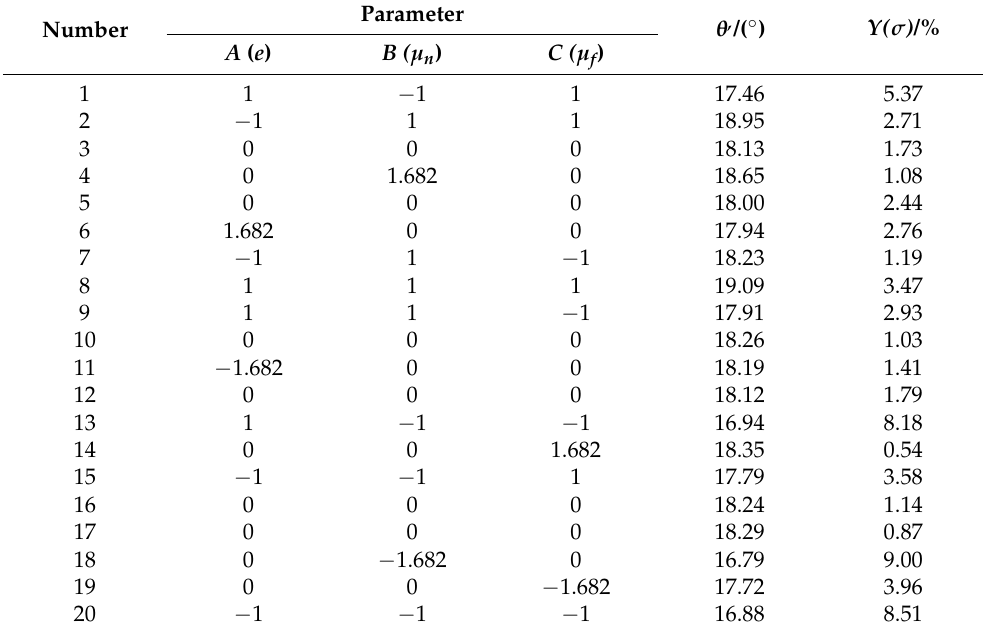
Table 13. Results of orthogonal rotation combination